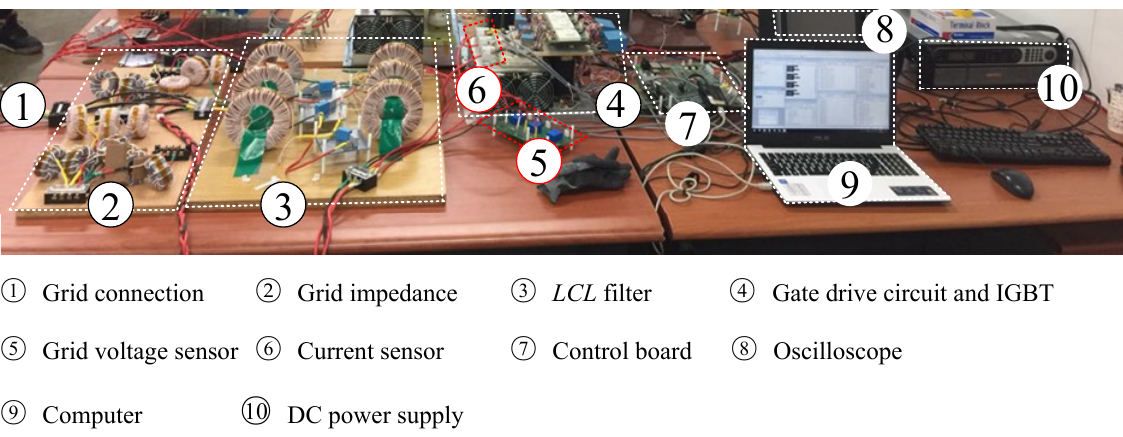
Figure 19. Experimental setup of the three-phase LCL filter type GcI under grid impedance, reprinted with permission from [22] Copyright 2021 Elsevier.